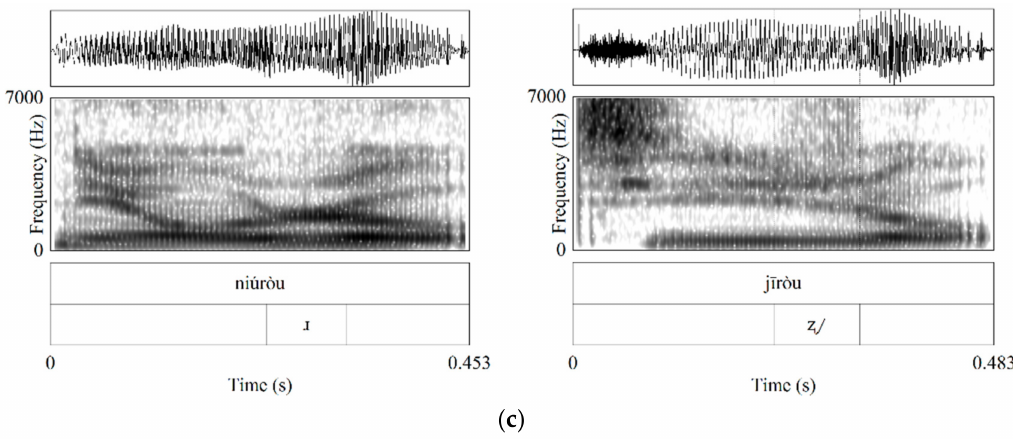
Figure 1. ( a ) Example of a typical tap ( left ) in Spanish pero /'pe R o/ ‘but’ and a typical trill with three closures ( right ) in perro /'pero/ ‘dog’ as produced by a native Spanish speaker (S01); ( b ) Example of a typical L2 English [ R ] ( left ) in water /'w A t @ô / and English / ô / ( right ) in arrest / @ ' ôE st/ as